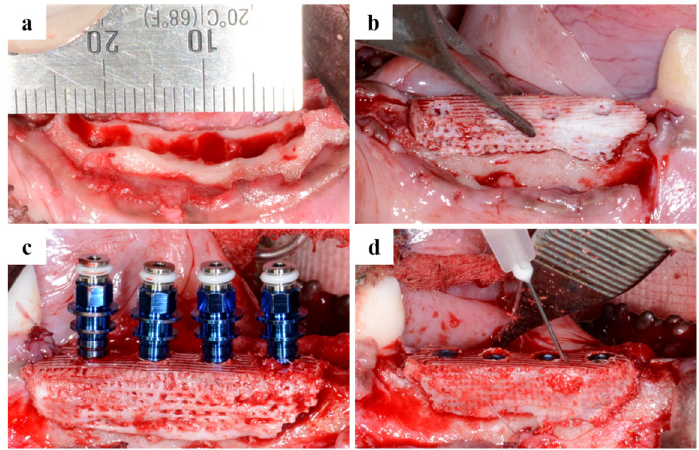
Figure 14. Surgical procedures: ( a ) The defect area after tooth extraction; ( b ) A scaffold was placed in the defect sites; ( c ) Progress of implant placement; ( d ) Application of the prepared BMP containing a medium.